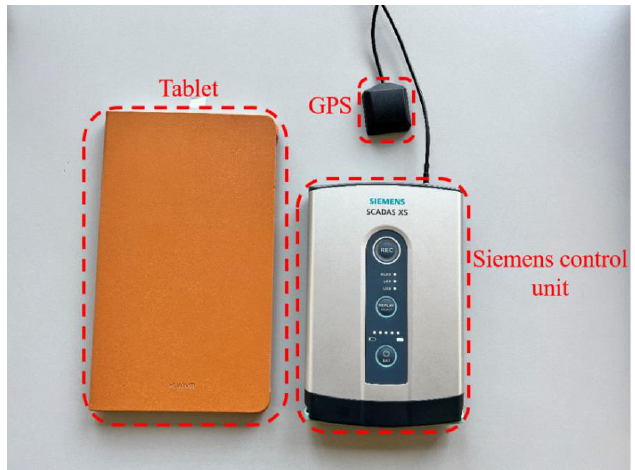
Figure 4. Instrumentation used for data acquisition. It consisted of a control unit provided by the Siemens company (model SCADAS XS Compact), a GPS sensor and a tablet for the monitoring.